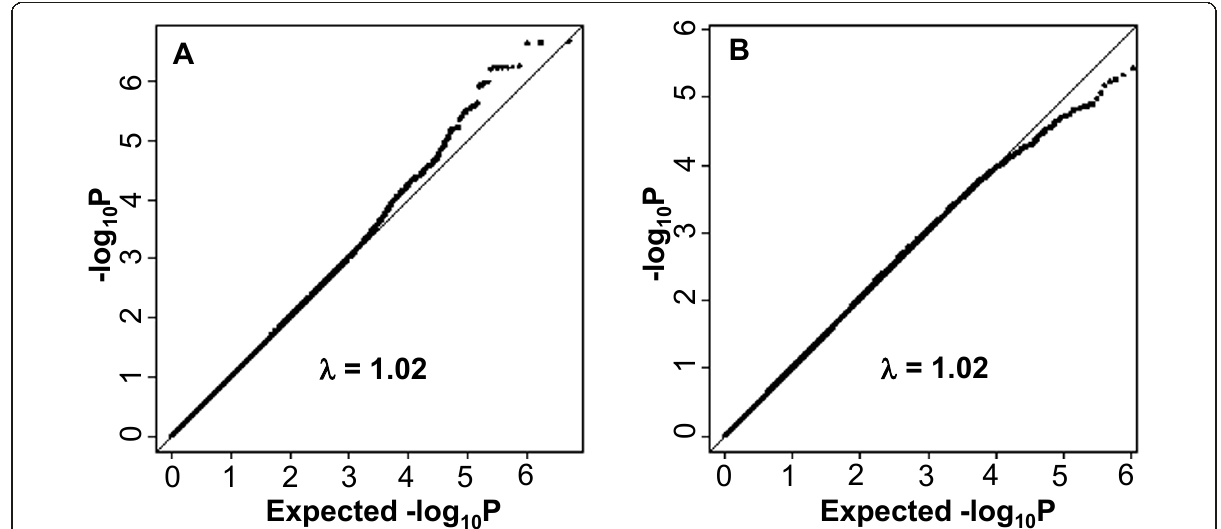
Figure 2 Renal sinus fat quantile-quantile plots for the genome-wide association analysis by sex . (a) Quantile-quantile plot for the genome-wide association analysis of renal sinus fat in women, adjusted for age and BMI. (b) Quantile-quantile plot for the genome-wide association analysis of renal sinus fat in men, adjusted for age and